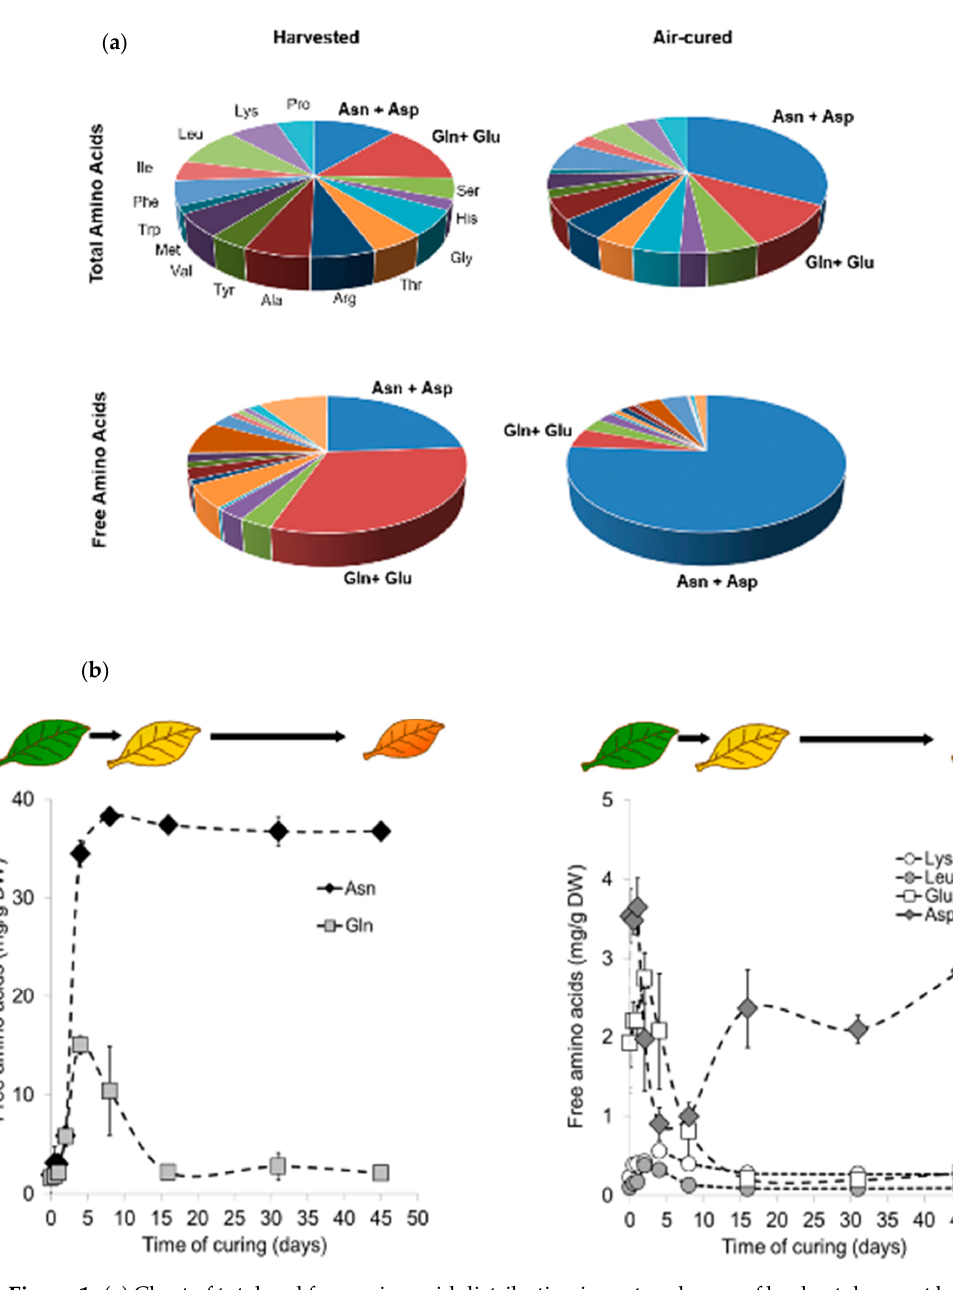
Figure 1. ( a ) Chart of total and free amino acid distribution in mature leaves of burley tobacco at harvest and after air curing. Each sector represents the frequency distribution (mg / g dry weight [DW]) of amino acids in the total amino acid fraction, and after hydrolysis (free amino acids) when the leaf tissue is harvested and air cured (45 days post-harvest). Data were collected from three biological replicates (n = 3). ( b ) Time course of the air curing e ff ect on the accumulation of asparagine and glutamine (left panel) and aspartate and glutamic acid (right panel) in tobacco burley leaves. The free amino acids were quantified at di ff erent time points during air curing. Data were collected from three biological replicates (n = 3). Each data point represents the mean free amino acid content (in mg / g of dry weight [DW]). Vertical bars are standard deviation (SD).